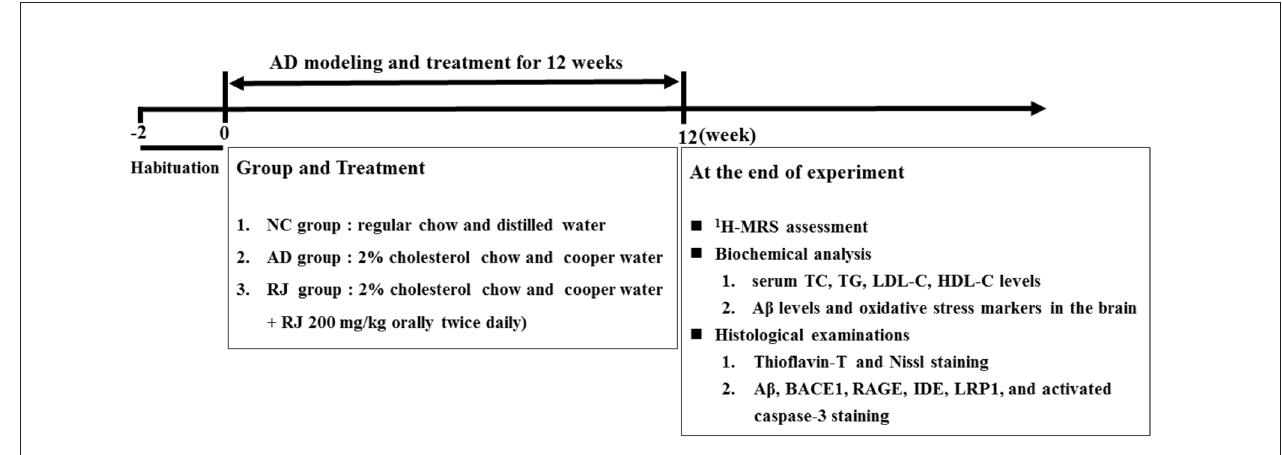
FIGURE 1 | A flowchart of the experimental design in this